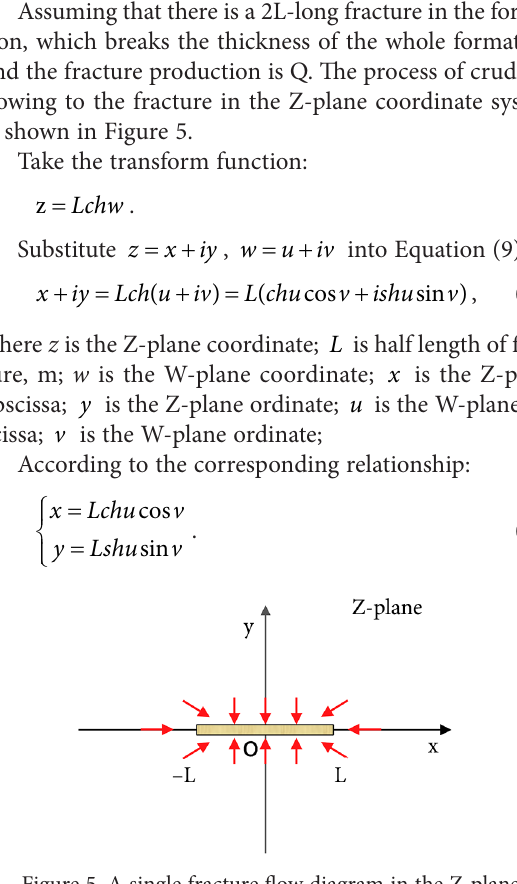
Figure 5. A single fracture flow diagram in the Z-plane coordinate